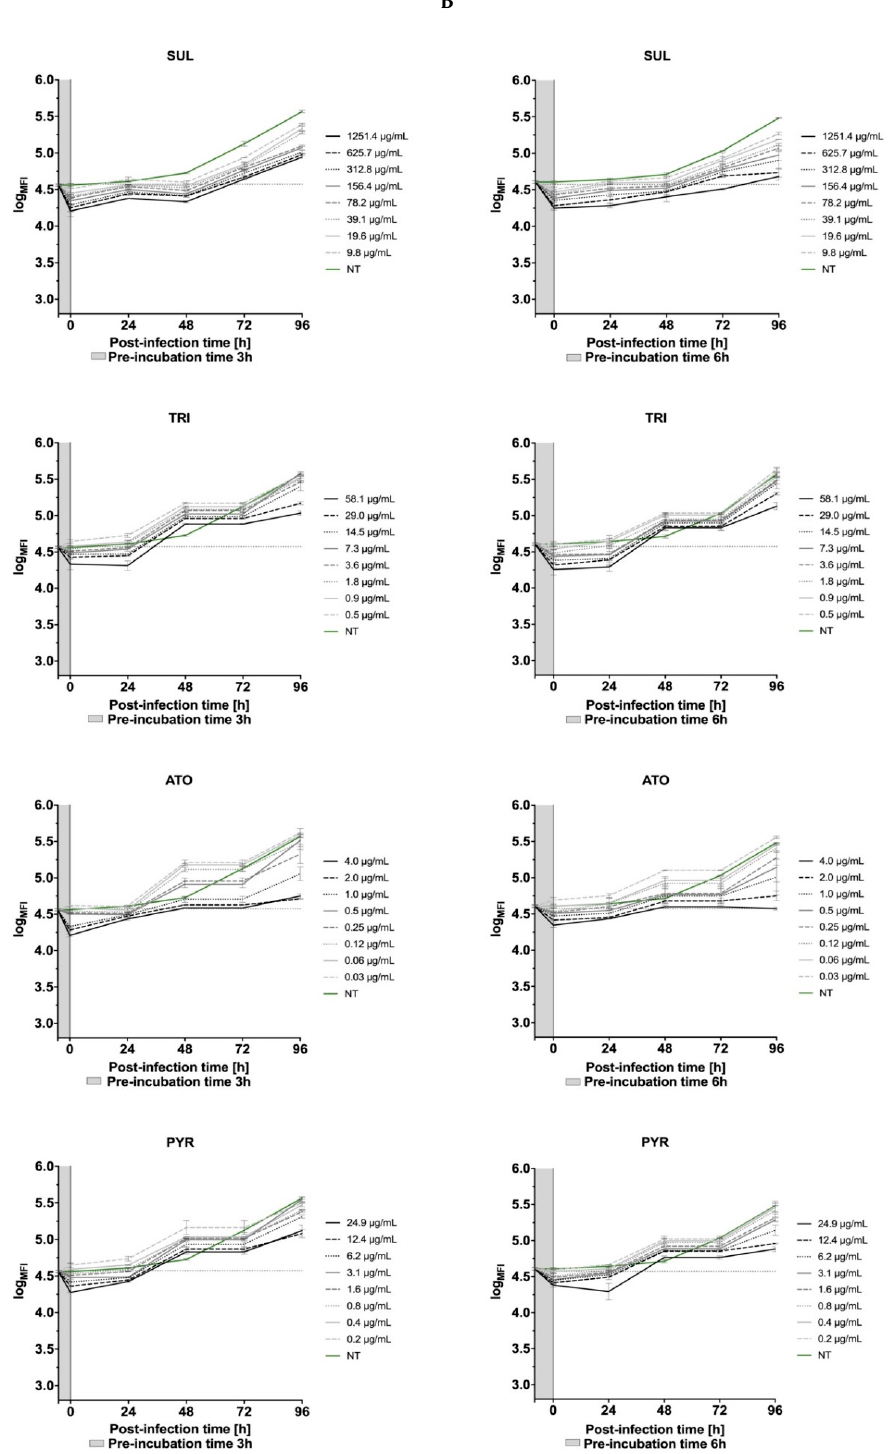
Figure 12. The kinetics of T. gondii growth. Concentration and time dependent curves of drugs against T. gondii RH- GFP strain. ( A ) Tachyzoites were given 1 h to allow them to infect host cells in the absence of compound and then were exposed to compounds for 96 h at 37 ◦ C. Fluorescence measurement was performed every 24 h. ( B ) Tachyzoites were exposed to drugs for 3 and 6 h at 37 ◦ C, then added to the Hs27 cells, incubated for 96 h at 37 ◦ C. Fluorescence measurement was performed every 24 h. Experiments were performed in triplicate, data presented as logarithm of mean fluorescence intensity (log MFI ). MFI—mean fluorescence intensity; SUL—sulfadiazine; TRI—trimethoprim; ATO—atovaquone;